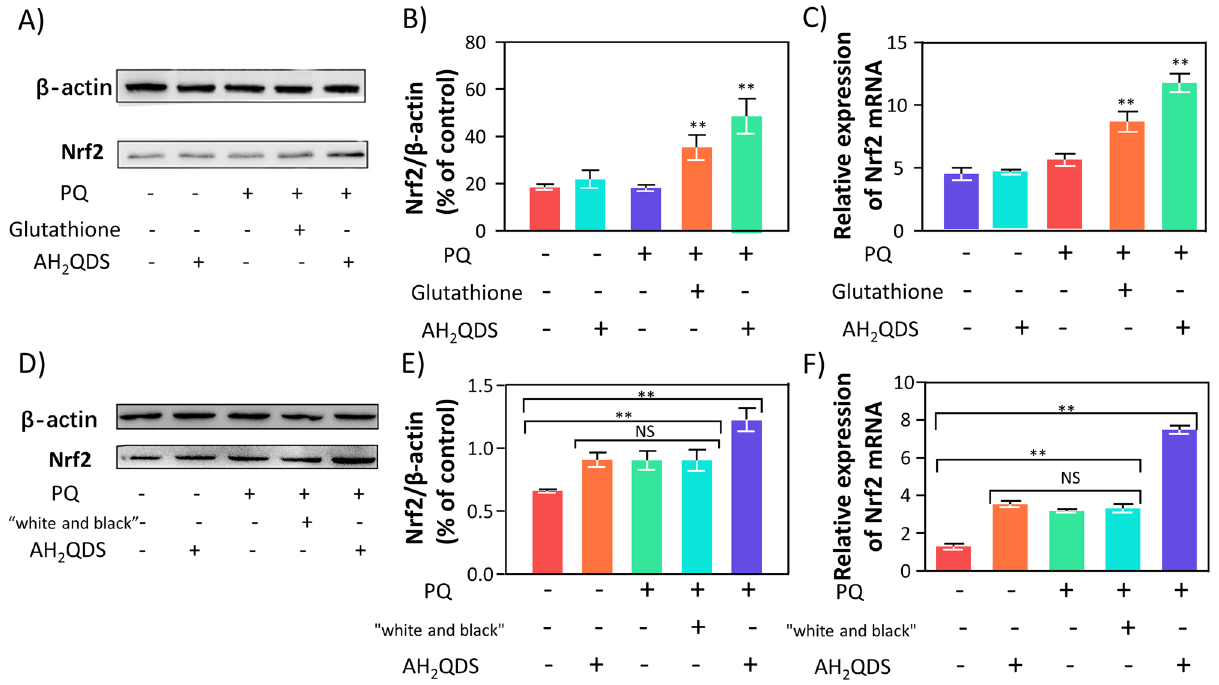
Figure 10. AH 2 QDS up regulated the expression of Nrf2. ( A – C ) After AH 2 QDS intervention, the expression of Nrf2 in A549 cells increased significantly. ( D – F ) The expression of Nrf2 in the lung tissue of rats detoxified by AH 2 QDS enhanced significantly. The grouping of gels/blots cropped from different parts of the same gel. Full- length gels and blots are included in Figure S6. Data are presented as means ± SEM, n = 3, NS = not significant, *P < 0.05, **P <